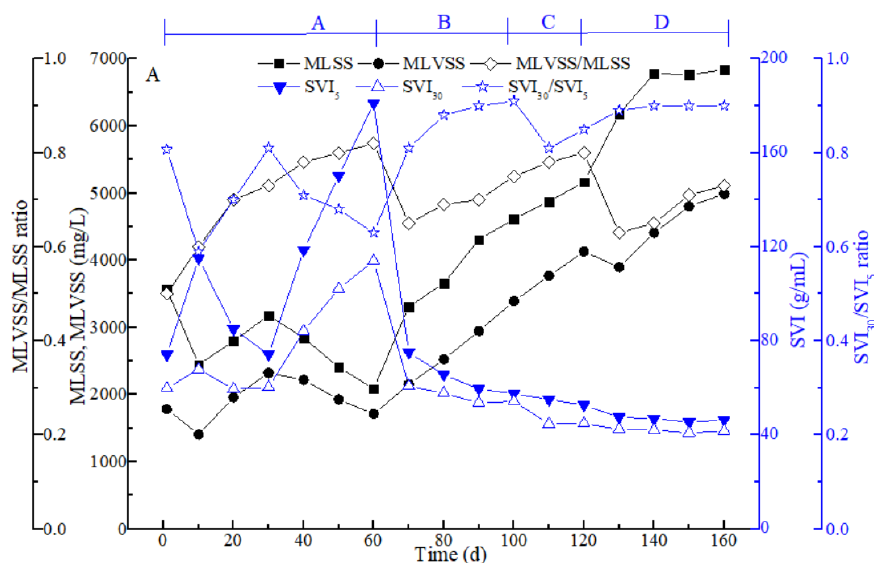
Figure 2. Variations of MLSS and SVI during the whole experiment. Stage A — filamentous AGS cultivation, stage B — stable running by adding 0.2 g/L sludge micropowder every 3 days, stage C — adding stirring for anaerobic process at 60 rad/min, stage D — adding 1.0 g/L sludge micropowder for partial denitrification every 4 days.